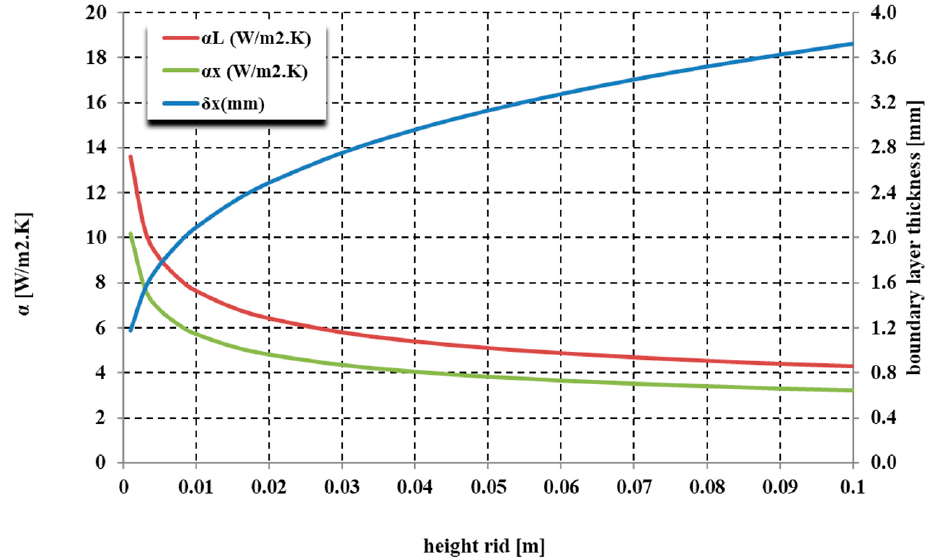
Figure 7. Dependence of boundary layer thickness and the average of heat transfer coefficient on the rib height. (wall temperature t w = 16 °C)